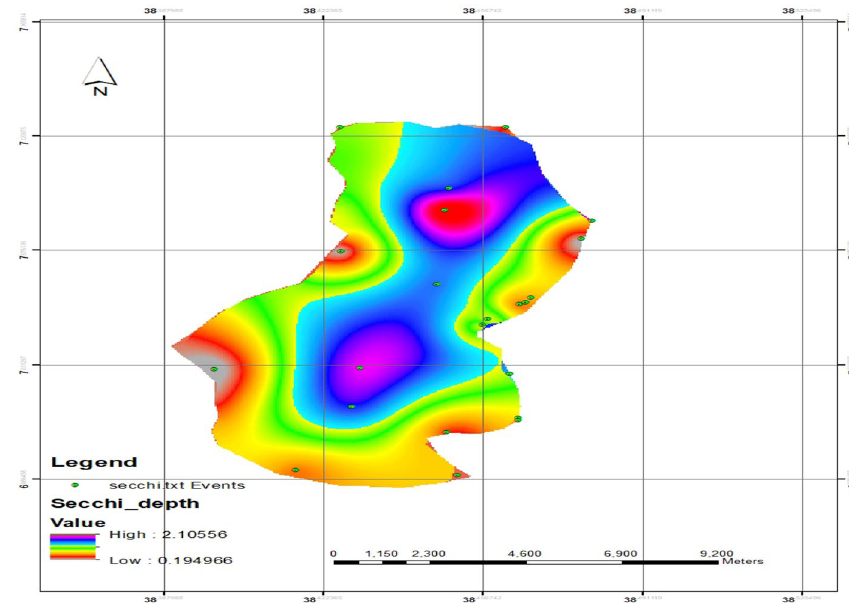
Fig. 4 Bathymetry expression Secchi depth of Lake